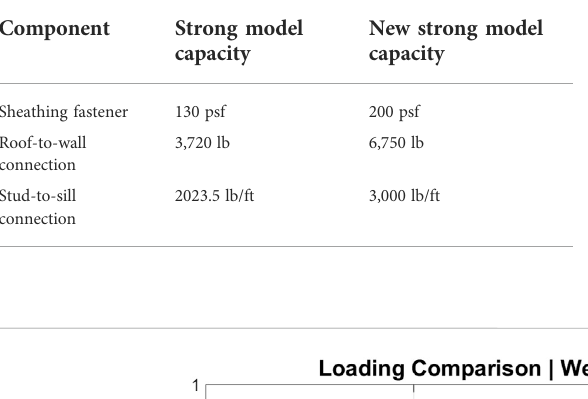
TABLE 4 Summary of component changes in new strong model.